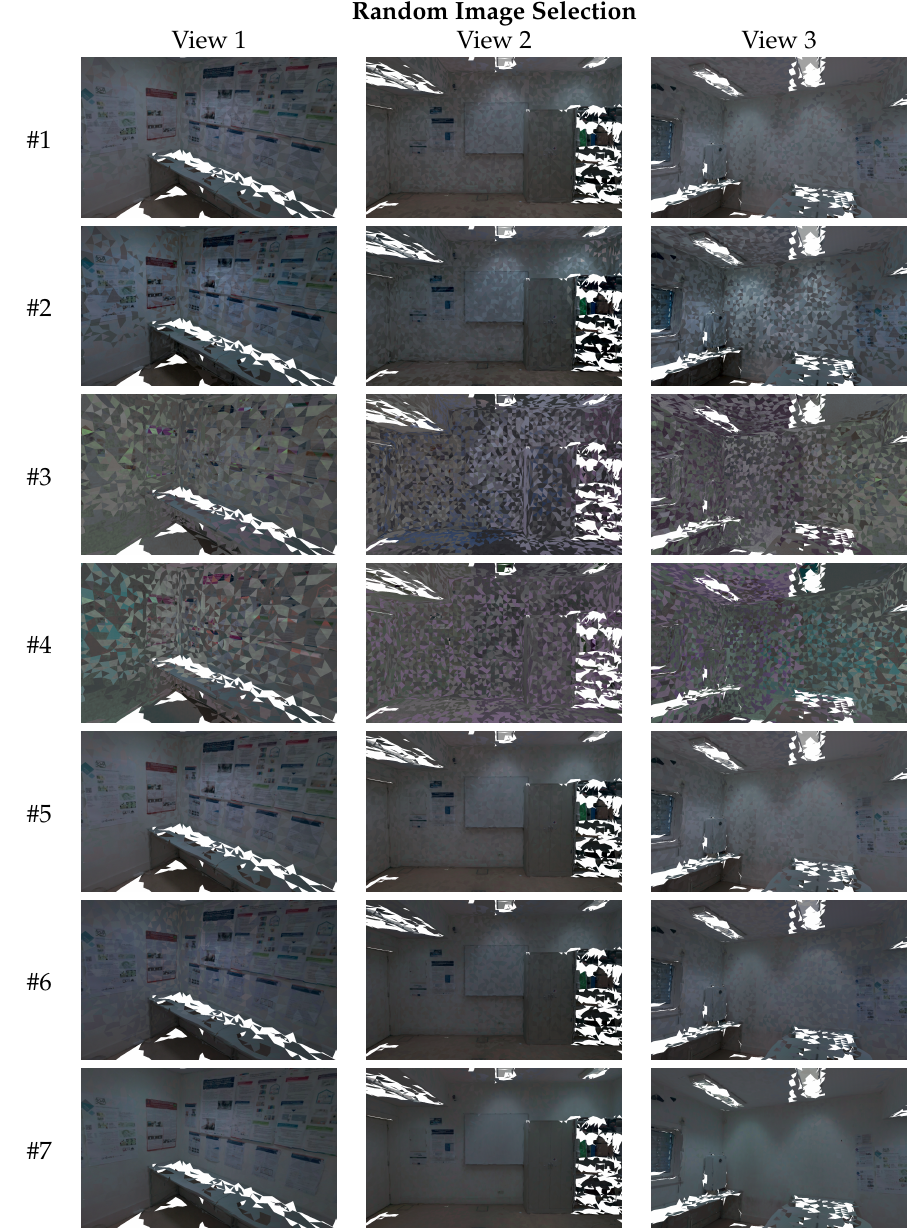
Figure 12. Mesh-based qualitative evaluation: textured meshes produced by each approach (rows) from three different viewpoints, and using the random image selection technique